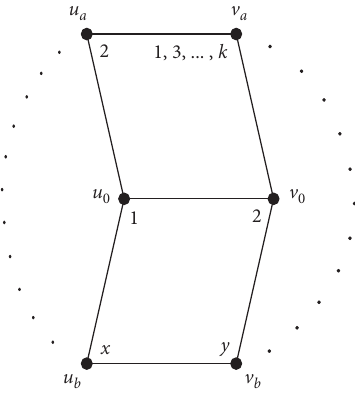
Figure 1: Illustration of Case 2.